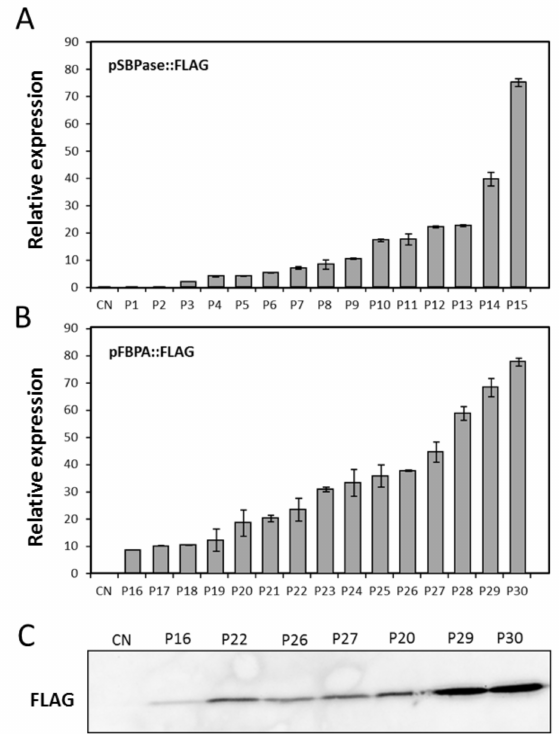
Figure 6. Analysis of transcript expression of the codon optimized P. umbilicalis cytochrome c 6 [12]) with a FLAG tag (CytC6-FLAG) gene driven by the B. distachyon ( A ) SBPase or ( B ) FBPA promoters in stably transformed wheat T0 lines. Relative expression levels and range of expression in these 30 independent transgenic plants compared to the expression of the endogenous SBPase in the same plants. Data are presented as a % of the endogenous SBPase expression and standard error of nine technical reps are shown. ( C ) FLAG-tagged protein accumulation in a selection of FBPA promoter wheat